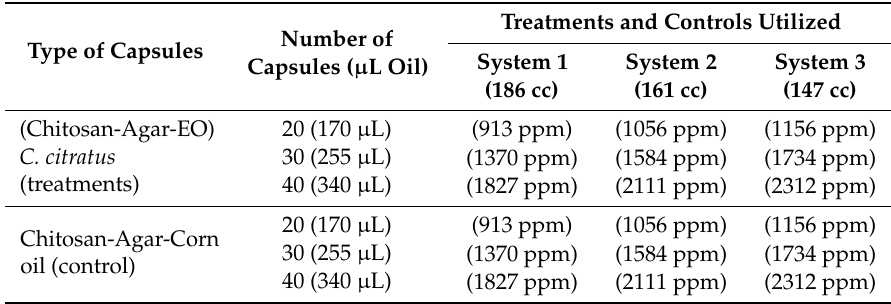
Table 4. Treatments and controls used to test the antifungal activity of (Chitosan-Agar-EO) capsules of Cymbopogon citratus,